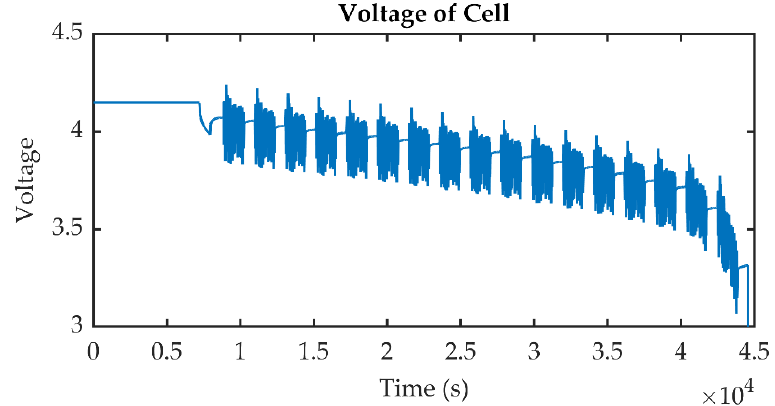
Figure 6. Battery voltage characteristic.